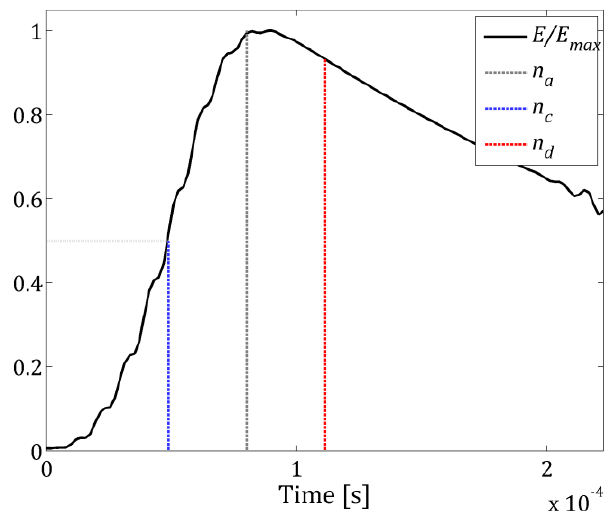
Figure 3. Normalized GW energy function E/E max with marked by blue and red dashed line time interval used for wavefield pattern estimation.